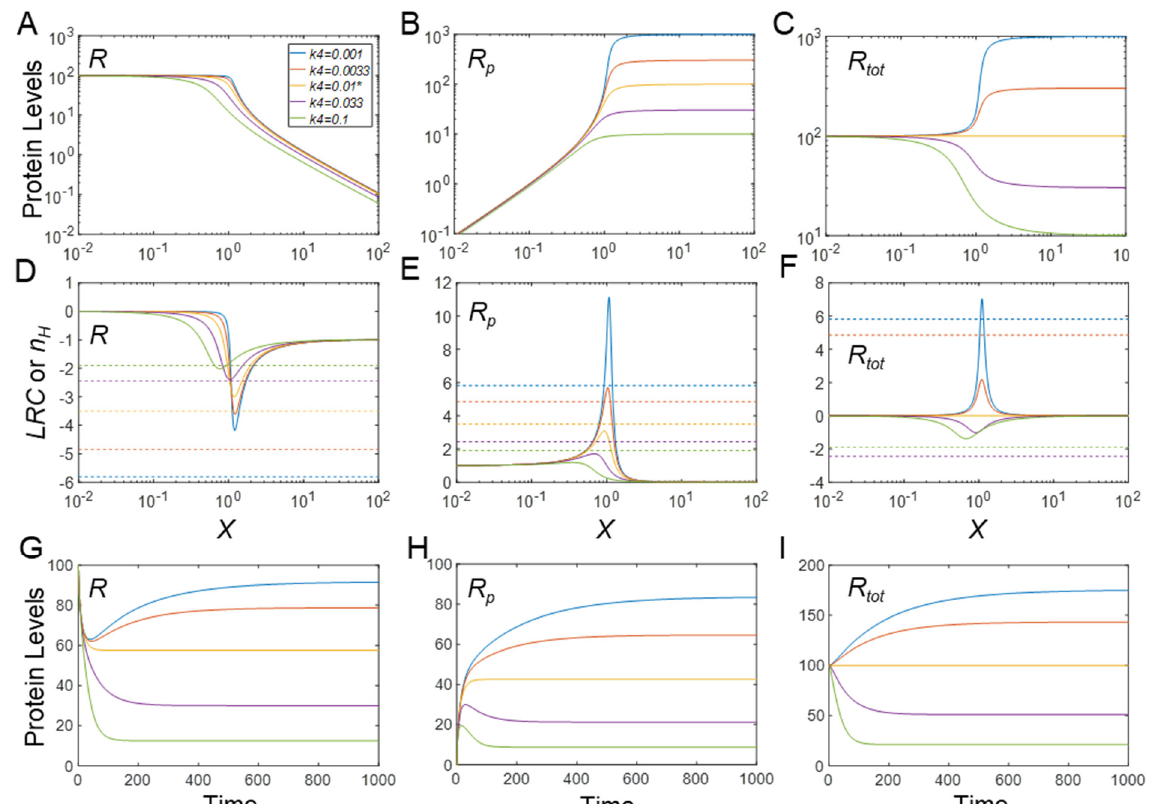
Figure 3. Effects of phosphorylation − induced changes in protein stability on ultrasensitivity and response time in the MM model. ( A – C ) Steady-state DR curves for R vs. X , R p vs. X , and R tot vs. X , respectively, for different values of k 4 , as indicated in panel ( A ). The same color scheme for k 4 values holds for all panels. ( D – F ) LRC (solid lines) and n H (dashed horizontal lines) pertain to R , R p , and R tot , respectively. ( G – I ) Response of R , R p , and R tot over time, induced by X = 1, respectively. * k 4 = 0.01 is the default value.